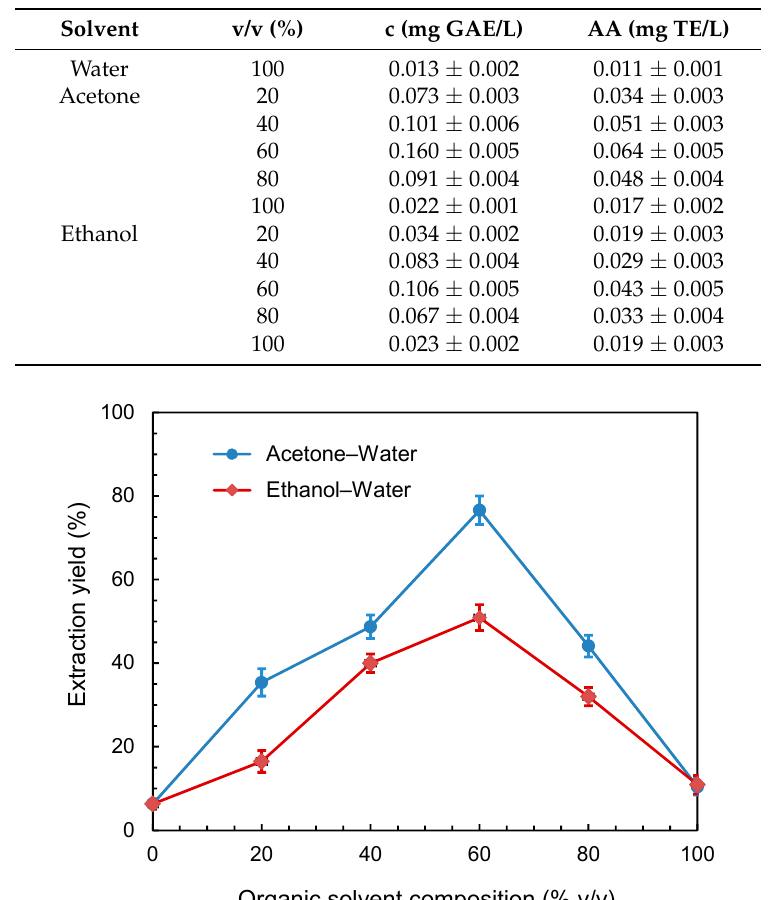
Table 1. Concentration of phenolic compounds (c) and antioxidant activity (AA) of water–organic solvent extracts from brewers’ spent grain (BSG). Data are expressed as mean ± standard deviation ( n = 3).